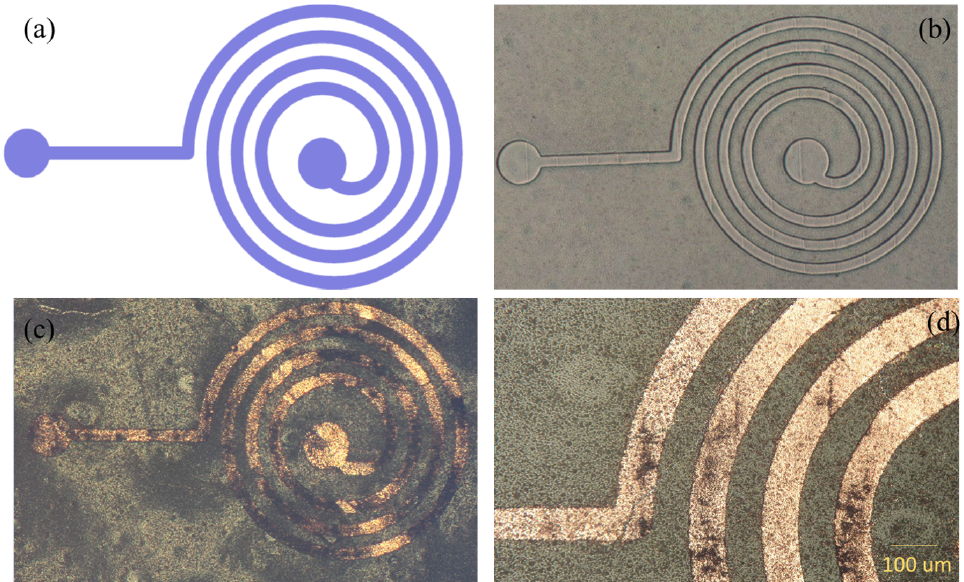
Figure 7. ( a ) The final optimized design for the planar inductor. ( b ) The pattern obtained after laser surface modification and cleaning of the surface as shown in step-II in Figure 2. ( c ) Planar inductor pattern after the Cu bath as shown in step-III in Figure 2. ( d ) An image of the fine spiral tracks made by SBU-CBM